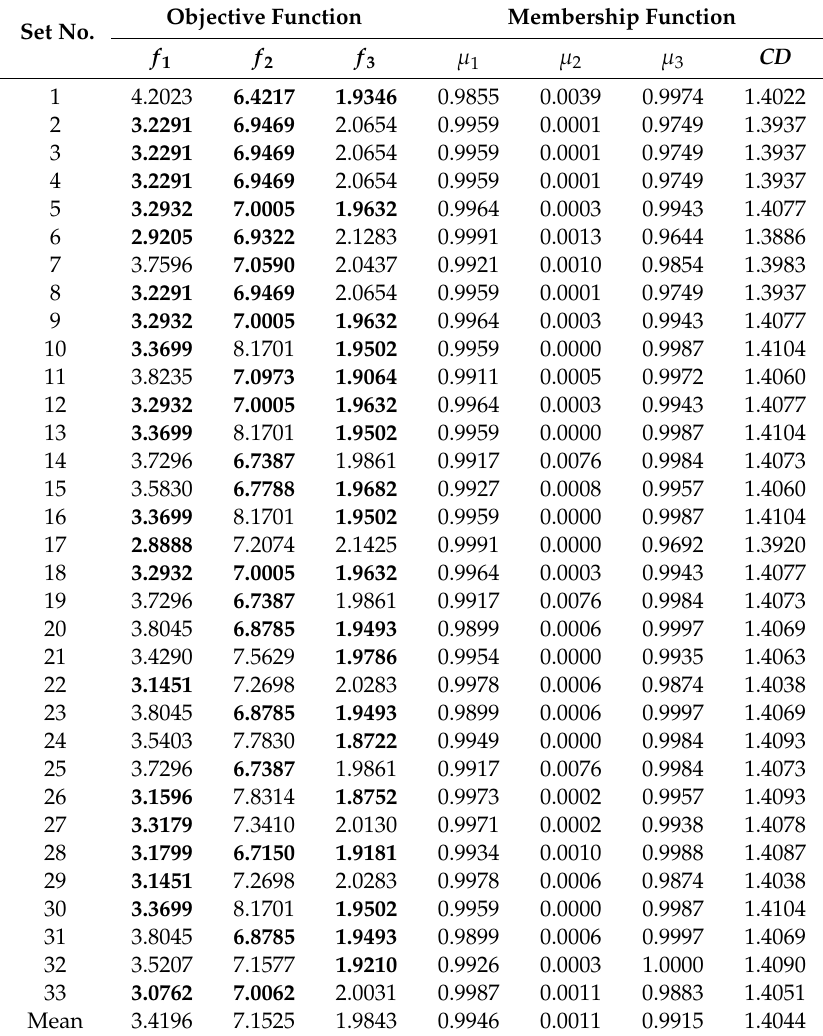
Table 1. Results of 33 independent runs with the proposed method and the membership function values in the Pareto set for each run. The values higher than the average value of the corresponding objective function are highlighted in bold; and the superior results for the three objectives presented against a gray